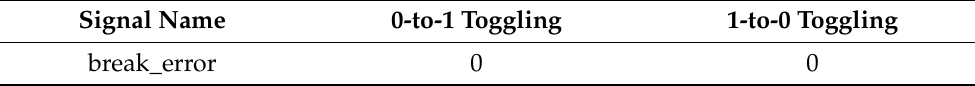
Table 1. Toggle coverage example: break_error is not